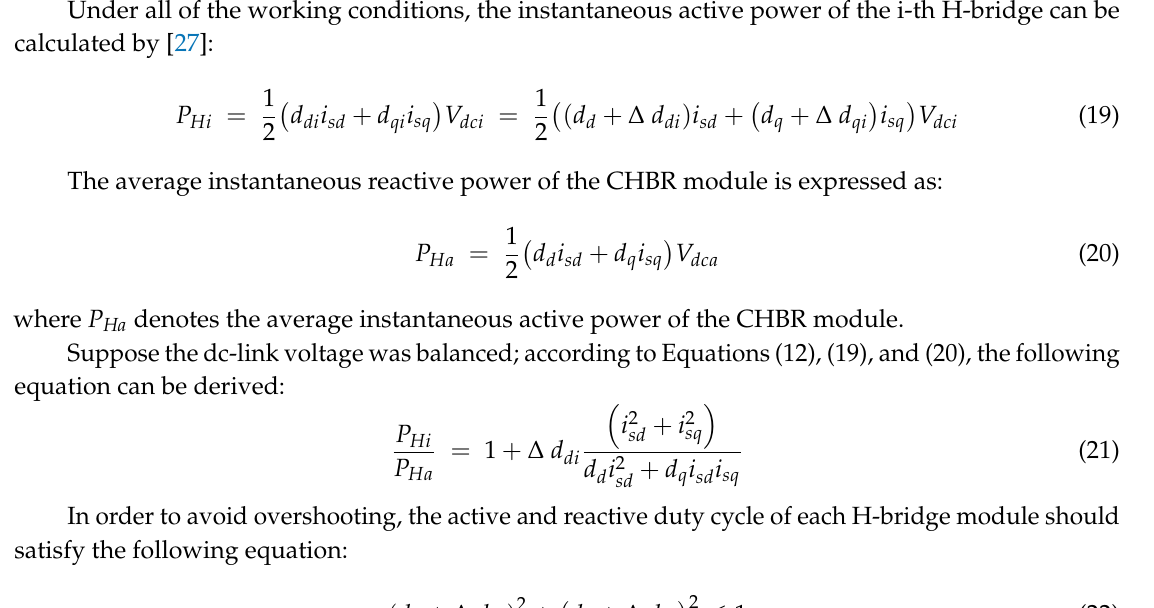
Figure 4. The block diagram of the proposed